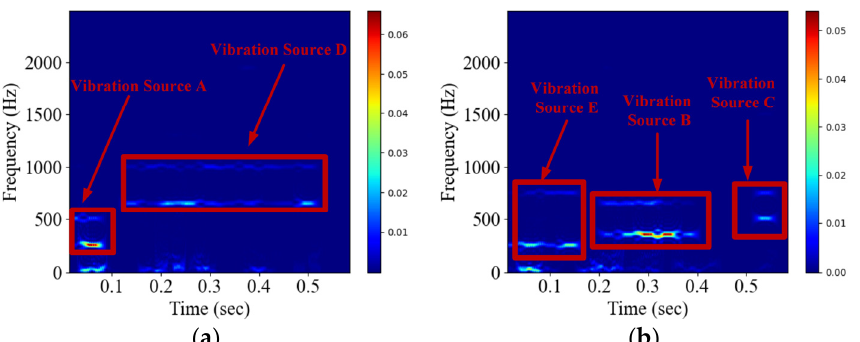
Figure 8. Time–frequency diagrams after image pre-processing: ( a ) data diagram with two vibration types of class A and D; ( b ) data diagram with three vibration types of class E, B, and C.